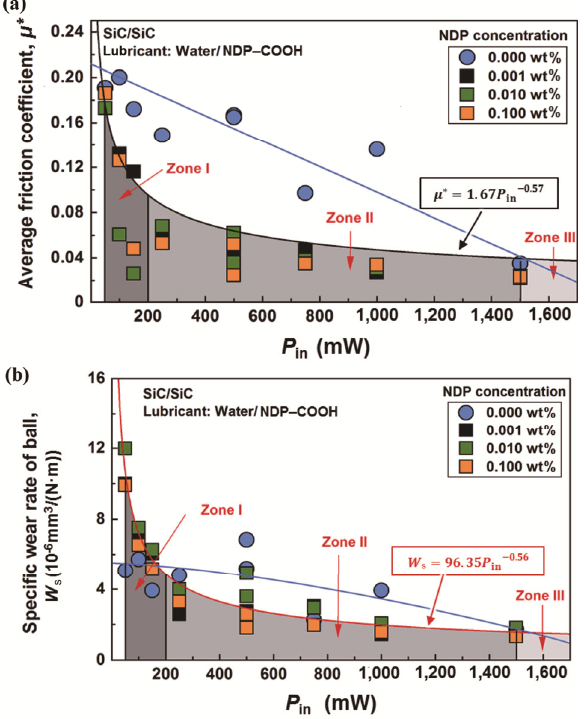
Fig. 15 Sliding properties at P values by lubricating in with NDP–COOH of various concentrations (0–0.1 wt%). Driving conditions are divided into three zones (Zone I: 50 mW < P < 200 mW; Zone II: 200 mW < P < 1,500 mW; in in Zone III: P > 1,500 mW) and distinguished by three gray in areas. (a) Evolution of average friction coefficients. Power curve is fitted from data of 0.001 wt% with a high coefficient of determination ( R 2 ) of 0.957. (b) Profiles of specific wear rates of SiC ball. Red curve indicates decreasing tendency and fitted from NDP–COOH data in 0.001 wt%, 0.01 wt%, and 0.1 wt% with R 2 = 0.93. Blue curves indicate performance tendency in the